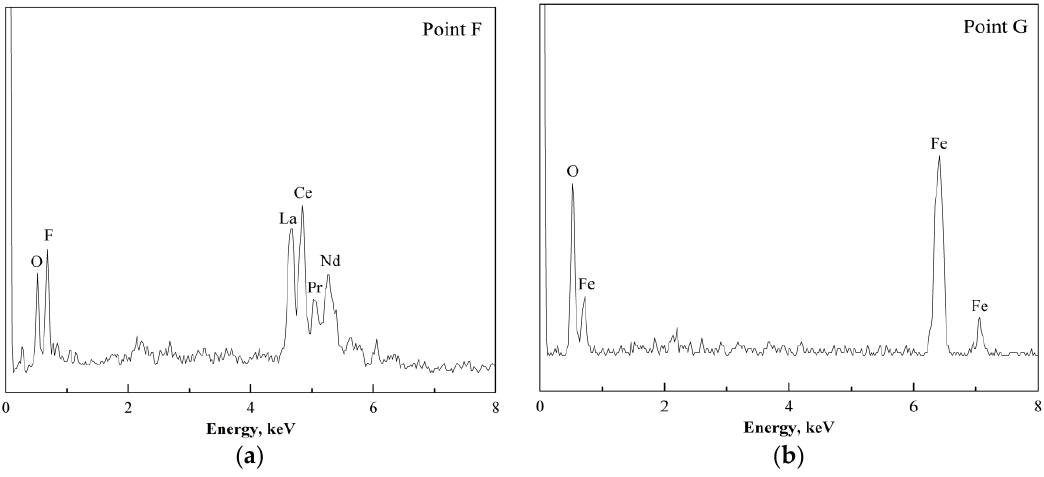
Figure 10. EDS results from Bayan Obo tailings after magnetizing roasting at 600 °C: ( a ) roasted bastnaesite; ( b ) Fe 3 O 4 . Table 5. EDS results from Bayan Obo tailings after magnetizing roasting at 600 °C. (wt. %). Analysis